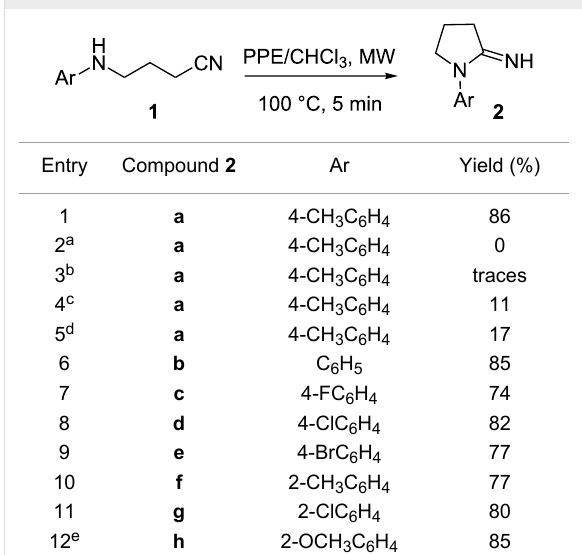
Table 1: Synthesis of 1-aryl-2-iminopyrrolidines